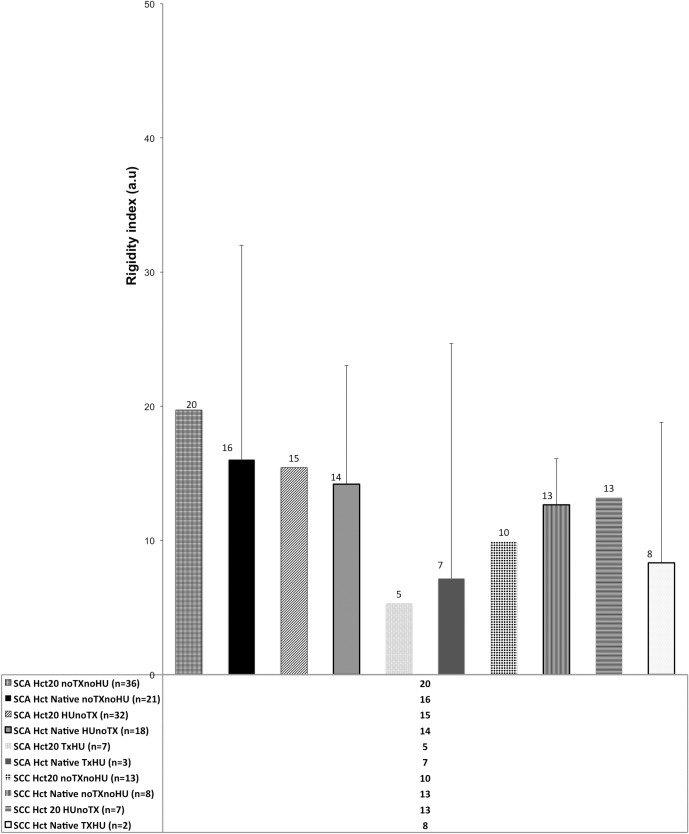
Comparison between the values of the rigidity index Ri in hematocrit Hct = 20 and Hct = native; SCA and SCC patients, n values shown in the figure.HU = in hydroxyurea therapy, TX = in transfusion therapy. NoHU = does not use hydroxyurea, no TX = does not use transfusion. Significance between the two data series (Hct = 20 and Hct = native), using the nonparametric Mann-Whitney test.